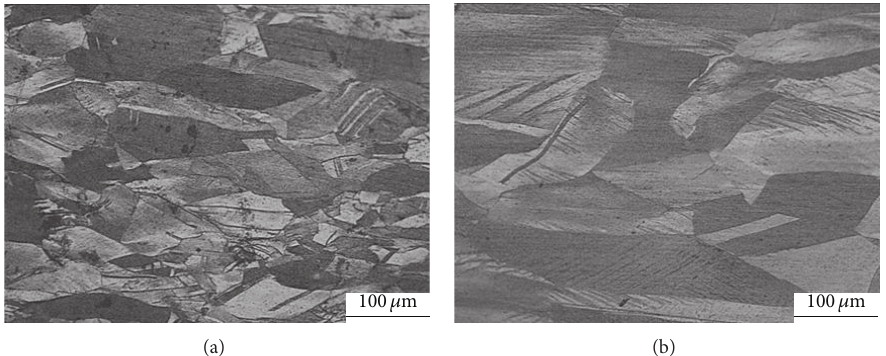
Figure 8: (a, b) Microstructure of Cu-2Al deformed to true axial strains of 0.5 in plane strain compression on the transverse section, for 70 𝜇 m and 250 𝜇 m, respectively.